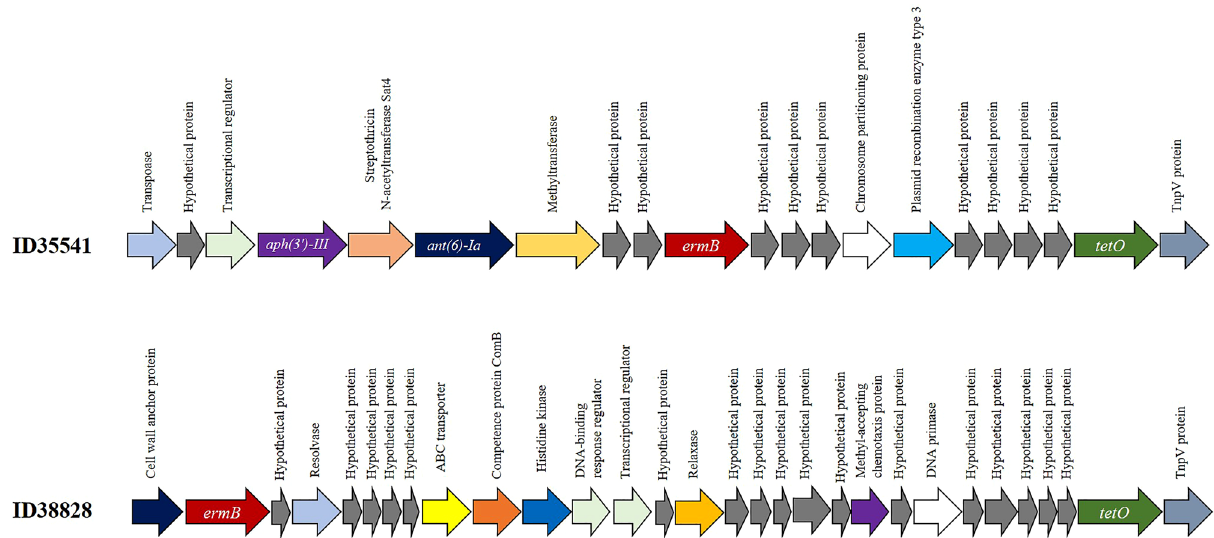
Figure 2. Genetic organization of antimicrobial resistant genes in two Streptococcus suis serotype 1